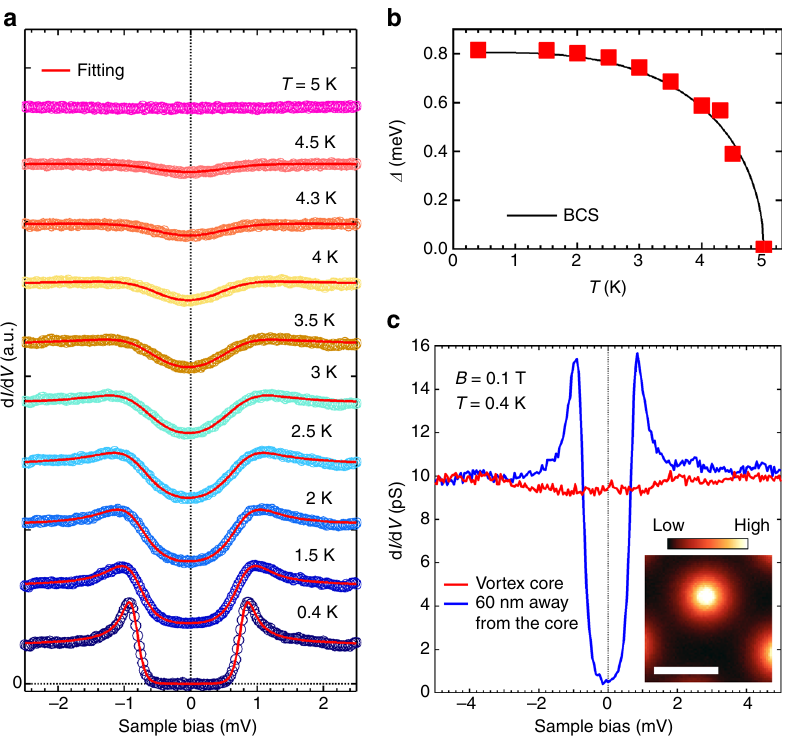
Fig. 4 Superconducting states at the surface. a d I /d V spectrum as a function of temperature. Set-up conditions were V = +10 mV, I = 200 pA. Bias modulation amplitude V r.m.s. was 18 μ V. Solid lines are fi tted Dynes functions with thermal broadening taking into account. For clarity, each spectrum is shifted vertically. b Temperature dependence of the superconducting gap Δ . A solid line denotes the weak-coupling BCS behaviour. c d I /d V spectrum at the centre of vortex core. T = 0.4 K and magnetic fi eld B = 0.1 T. For comparison, d I /d V taken at 60 nm away from the core is also plotted. Set-up conditions: V = +10 mV, I = 100 pA. V r.m.s. = 35 μ V. d I /d V map at V = 0 mV is shown in the inset. Set-up conditions: V = +10 mV, I = 100 pA. V = 350 μ V. The scale bar corresponds to 100 r.m.s.